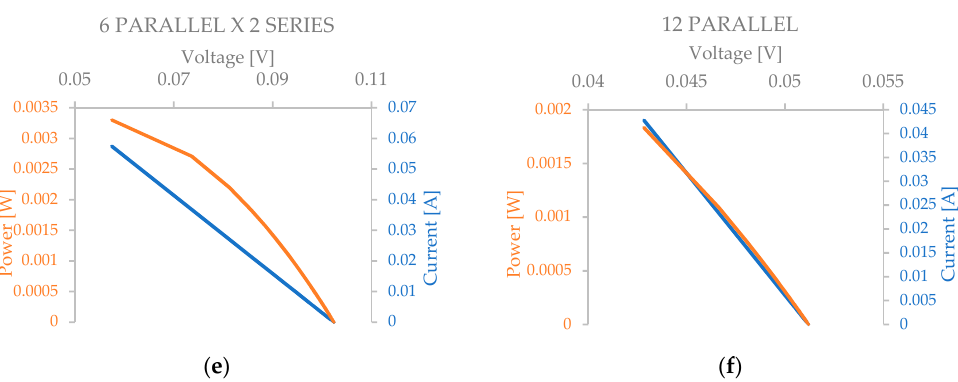
Figure 9. Multicell current–voltage (blue trace) and power–voltage (orange trace) simulation analysis with Δ T = 16 °C. ( a ) series of 12 cells, ( b ) 6 series of 2 parallel cells, ( c ) 4 parallels of 3 series cells, ( d ) 3 parallels of 4 series cells, ( e ) 2 parallels of 6 series cells, and ( f ) 12 parallel cells.